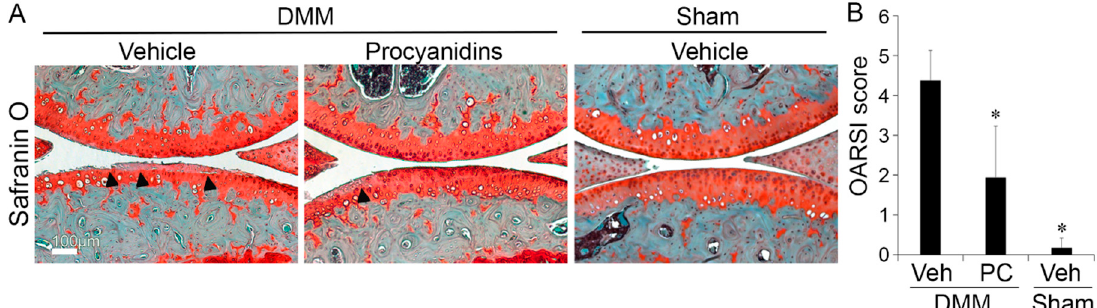
Figure 1. Oral administration of procyanidins slowed destabilization of the medial meniscus (DMM)-induced OA disease progression in mice. Mice subjected to DMM were treated daily with procyanidins (PC) or vehicle (Veh) by oral gavage. The articular cartilage of the DMM-wounded knee in mice treated with procyanidins exhibited a reduced loss of cartilage as visualized by Safranin-O staining ( A ) and lower Osteoarthritis Research Society International (OARSI) scores ( B ) at 8 weeks following surgery compared to the articular cartilage of the DMM-wounded knee in mice treated with vehicle. Black arrows denote representative areas of cartilage degradation, such as proteoglycan loss, cartilage fibrillation and/or erosion. Regions of red indicate staining of proteoglycans in the articular cartilage, meniscus, or growth plate, by Safranin-O. The regions of light blue-green indicate subchondral bone. Scale bar = 100 µm. * p < 0.05 by t -test; n = 4/group.